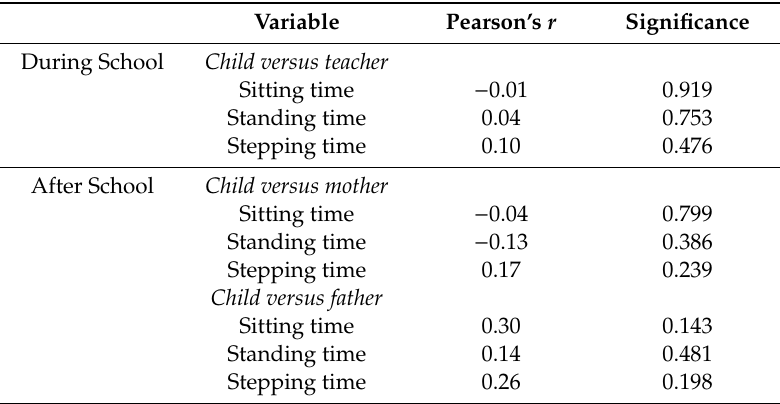
Table 4. Sedentary behaviour associations between participant groups.